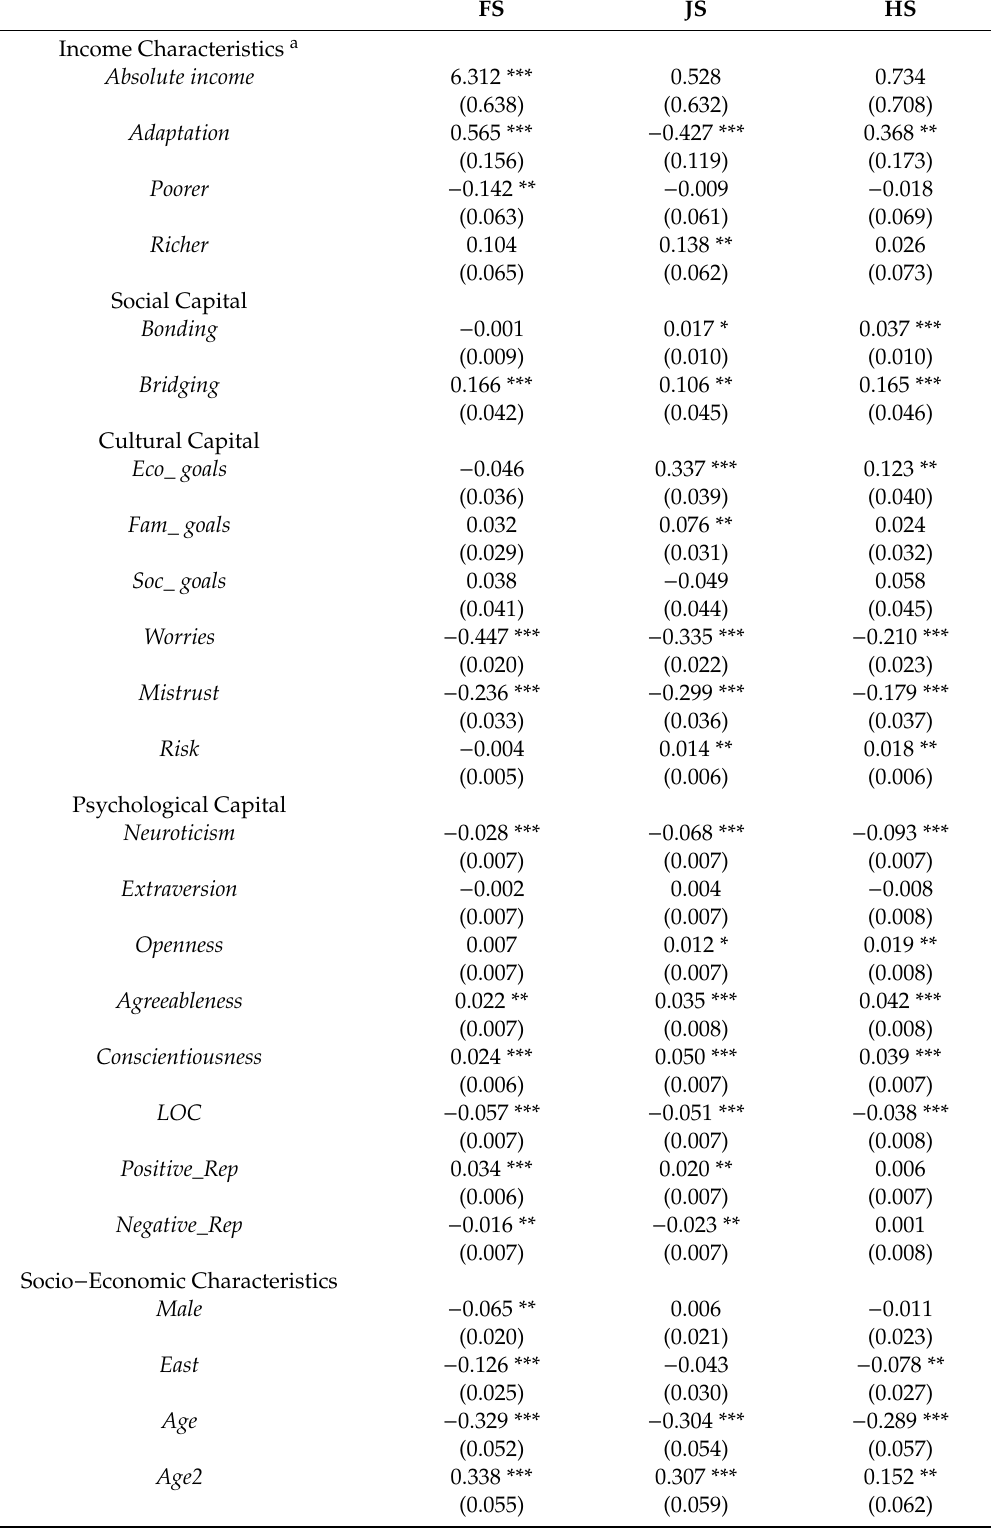
TableA2. EstimationresultsfordomainsatisfactionsofGermancitizens, 1998 − 2014(withoutdistinguish between specific